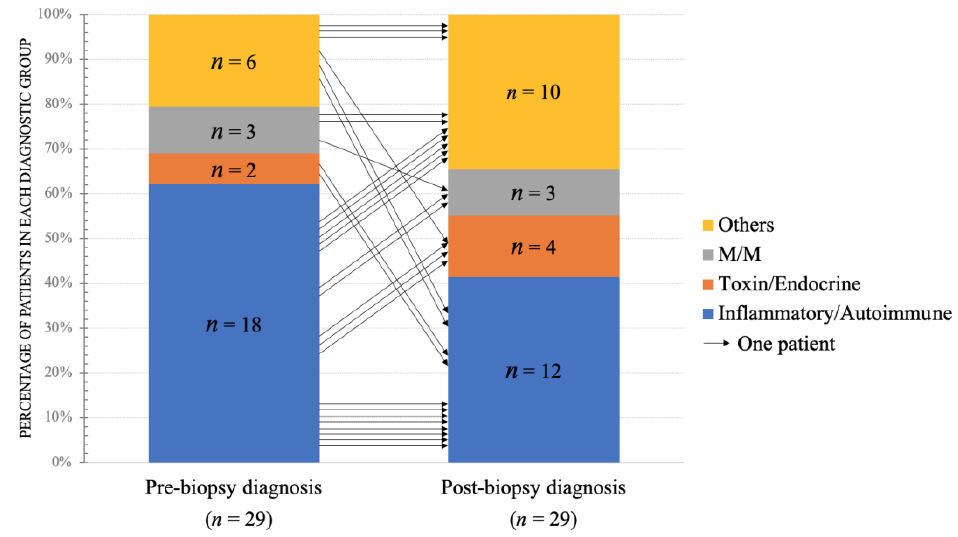
Figure 2. Comparison of pre- and post-biopsy clinical diagnoses in the group with change. A total number of 29 patients in the group with change was demonstrated. The vertical axis represented the percentage of patients in each diagnostic group. Each arrow represented one patient and showed the corresponding change of diagnosis after muscle biopsy. n , number of patients. M/M, metabolic/mitochondrial diseases.